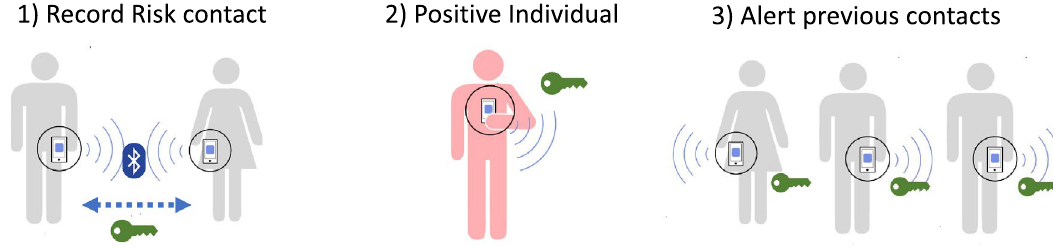
Figure 1. Digital contact tracing: ( 1 ) when the smartphones of two users are in range, they exchange their anonymous key codes; ( 2 ) if an individual is detected positive, it starts a process for tracing and identifying the previous contacts; ( 3 ) users are notified about a risky